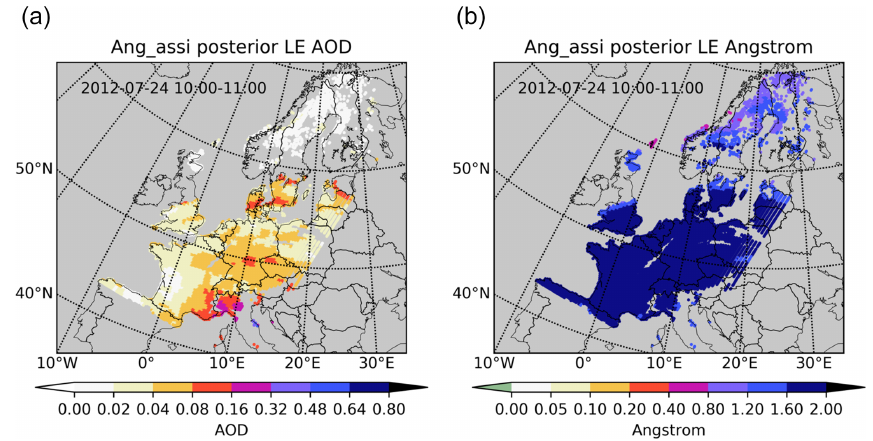
Figure 7. Posterior LOTOS-EUROS simulations of AOD (a) and Ångström exponent (b) on 24 July, 10:00 to 11:00UTC after Ångström